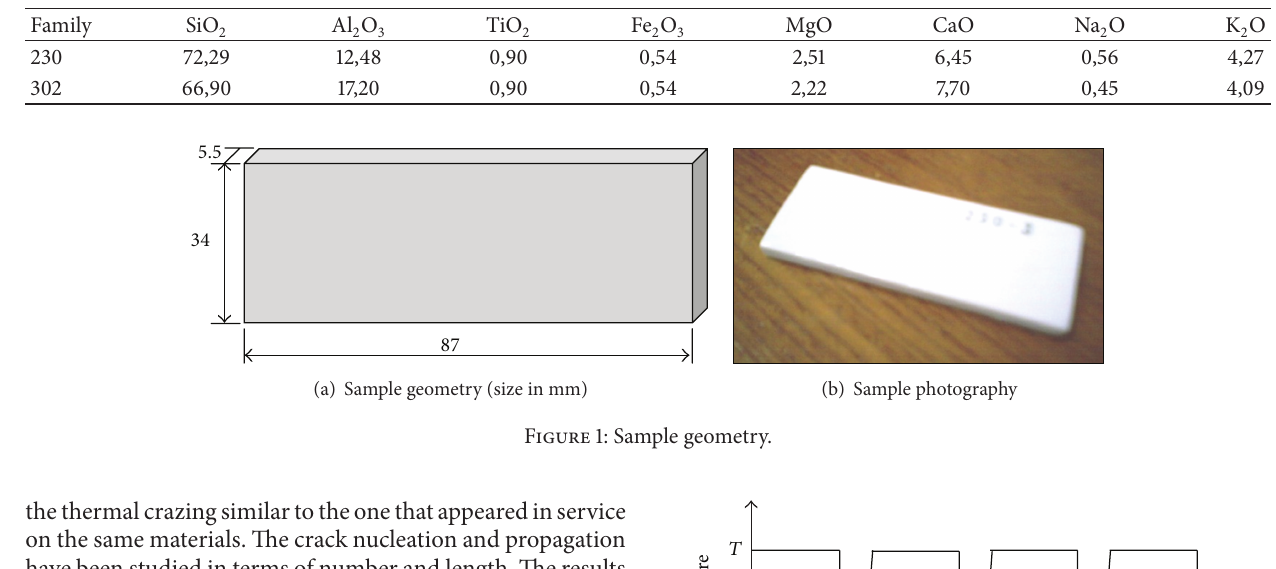
Table 1: Chemical composition (wt.%) of the glazed layers.